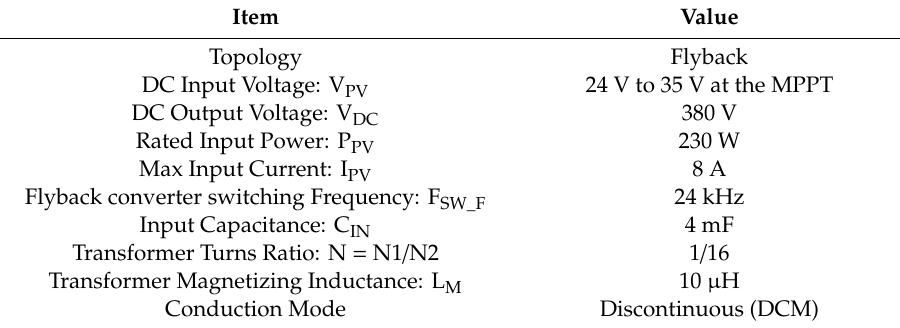
Table 2. Values of the DC-DC stage.